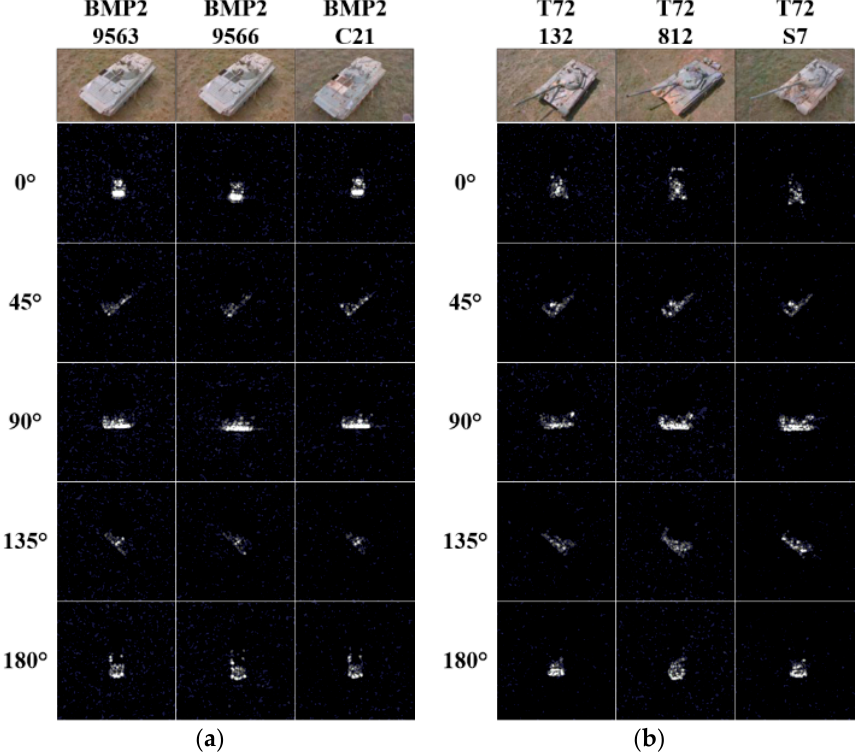
Figure 2. The optical images and SAR images of the targets. ( a ) BMP2 configurations; ( b ) T72 configurations. Table 4. The recognition results for configurations of BMP2.